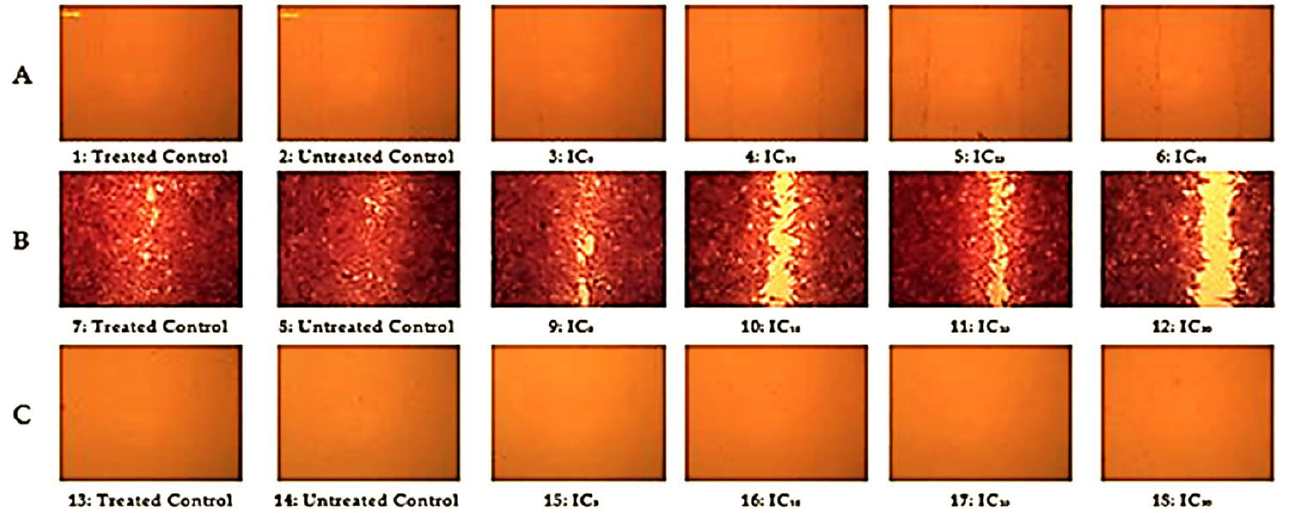
Figure 3. The impact of the methanol extract of R. vesicarius shoots on the cell-cycle progression of HepG2. ( A ) Microscopic reflection (20× magnification) of HepG2 cell line images at 0 h. ( B ) Microscopic reflection of cell line images after staining. ( C ) Microscopic reflection of cell line images after 26 h. The photomicrographs refer to the control groups and those treated at different doses of the plant extract at regular intervals.